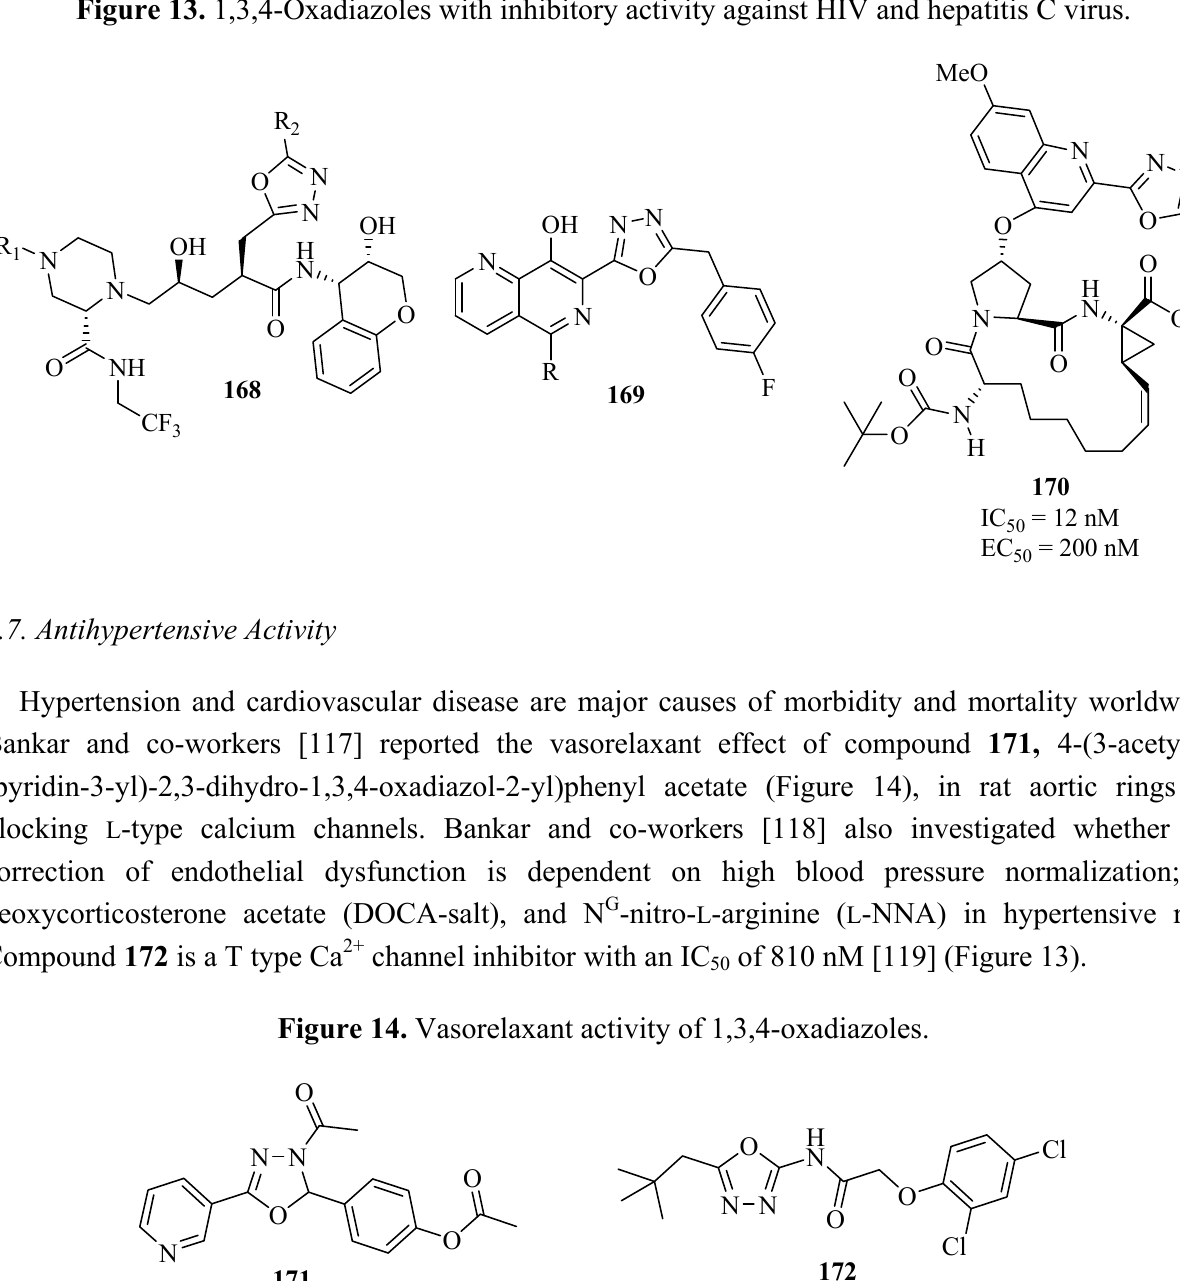
Figure 13. 1,3,4-Oxadiazoles with inhibitory activity against HIV and hepatitis C virus.